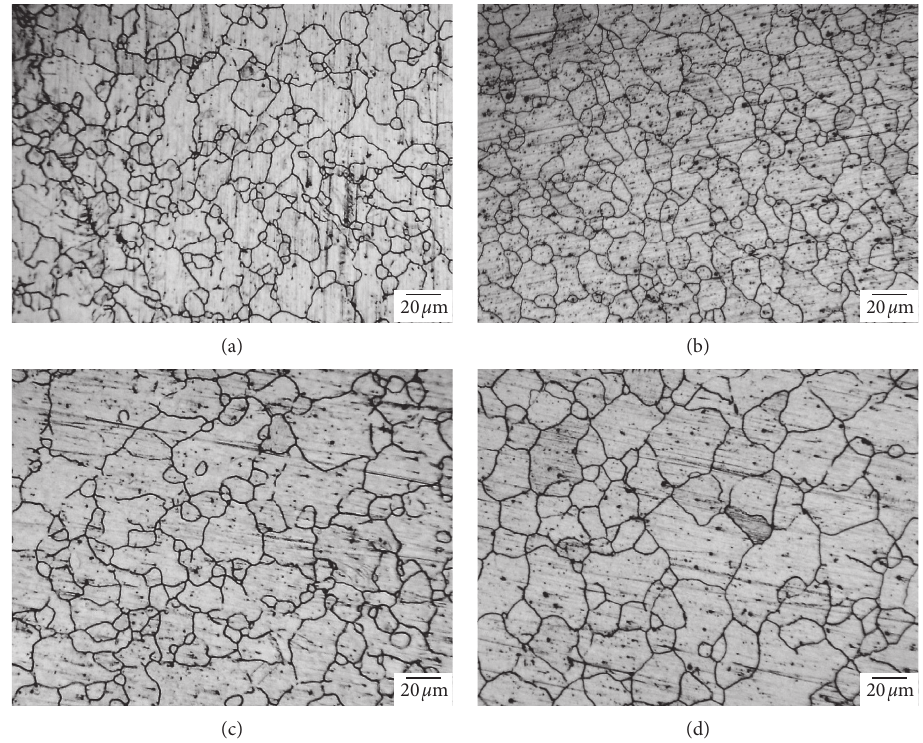
Figure 11: The metallographic structure of the longitudinal section at different